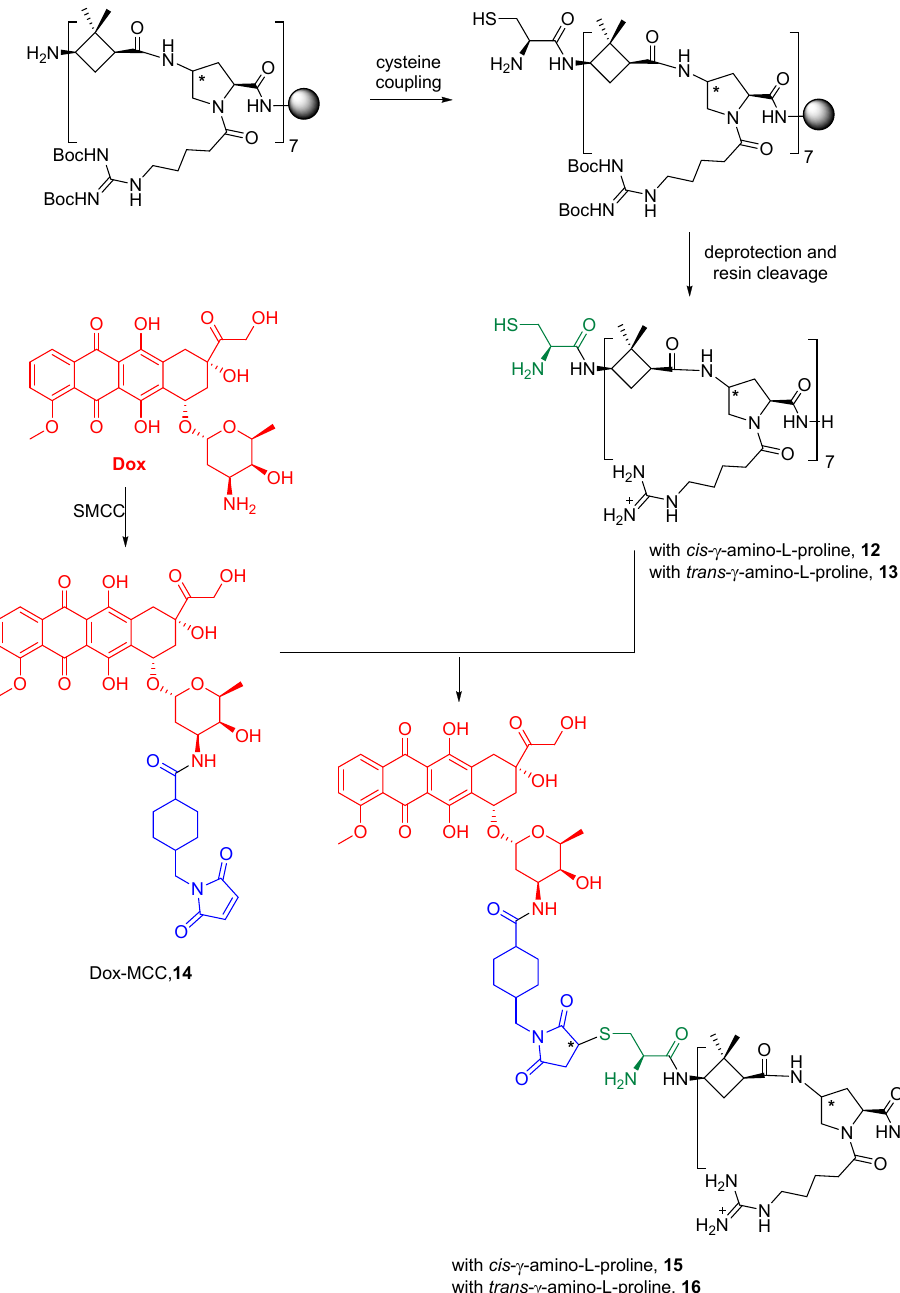
Scheme 1. Conjugation of doxorubicin to γ -CC 15 and γ -CT 16 peptides. The Dox moiety is highlighted in red, the cysteine residue in green, and the linker in blue.